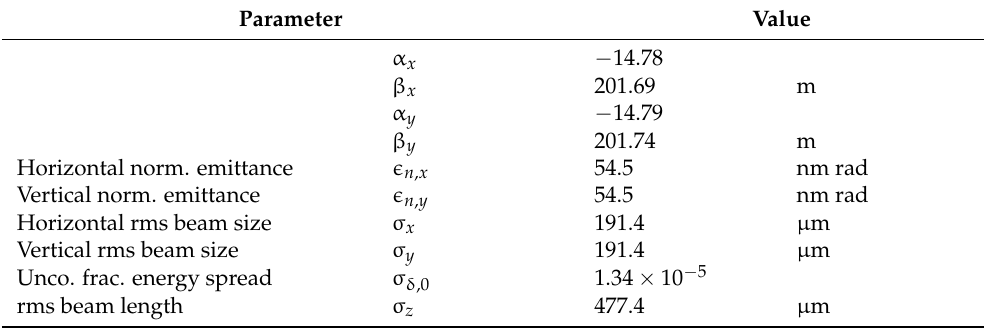
Table 7. Twiss parameters and other beam properties at the photoinjector exit. Beam energy 153 MeV.